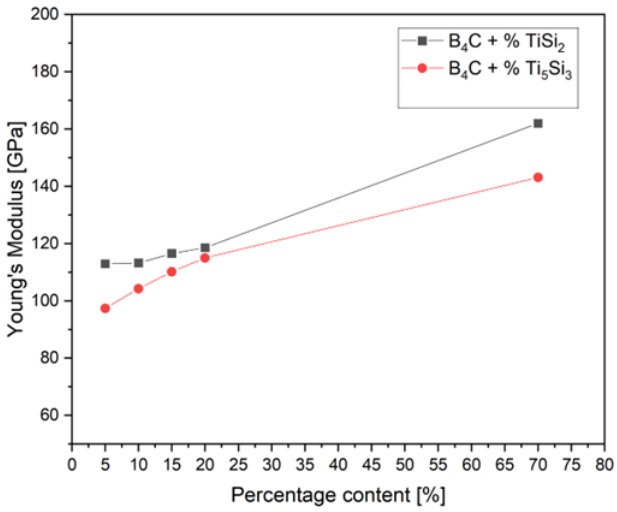
Figure 3. Young’s modulus of the composites as a function of the percentage of various additives.